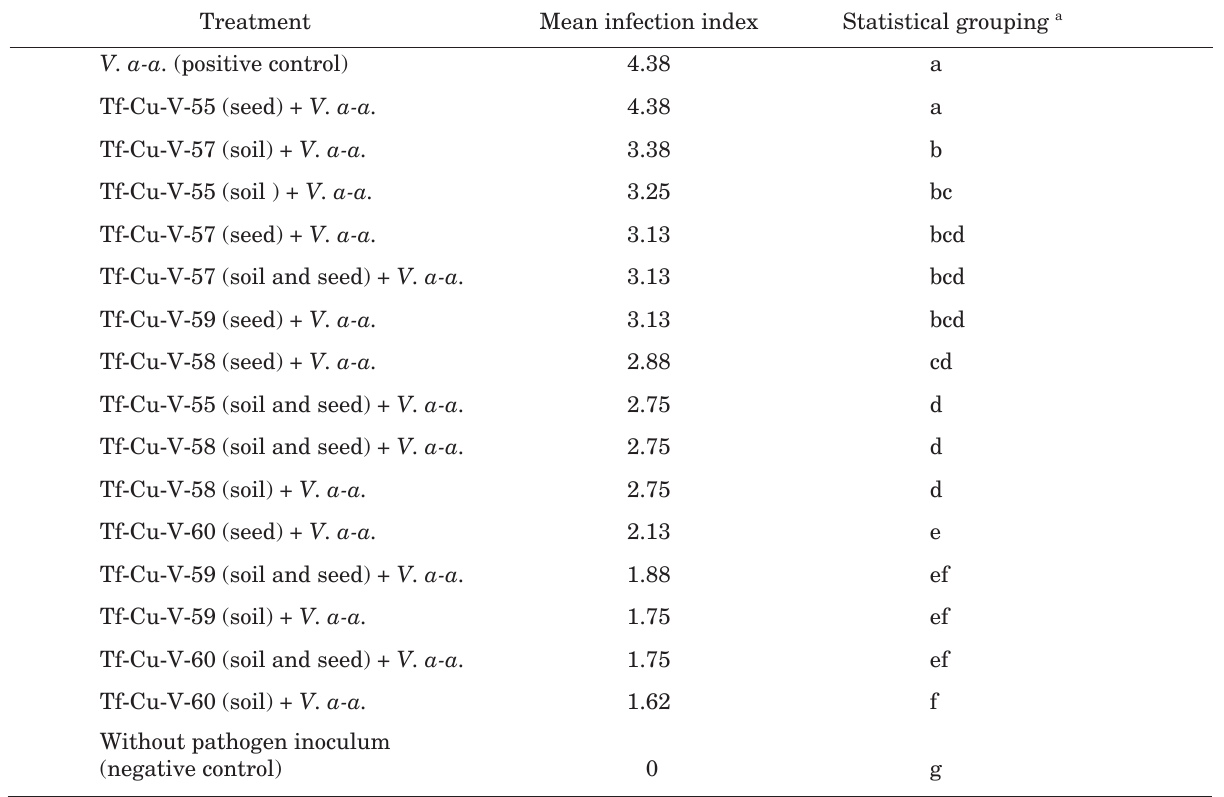
Table 3. Interactive effects between the main factor and subfactors (all treatments) on the Verticillium wilt infection index in greenhouse cucumber plants.